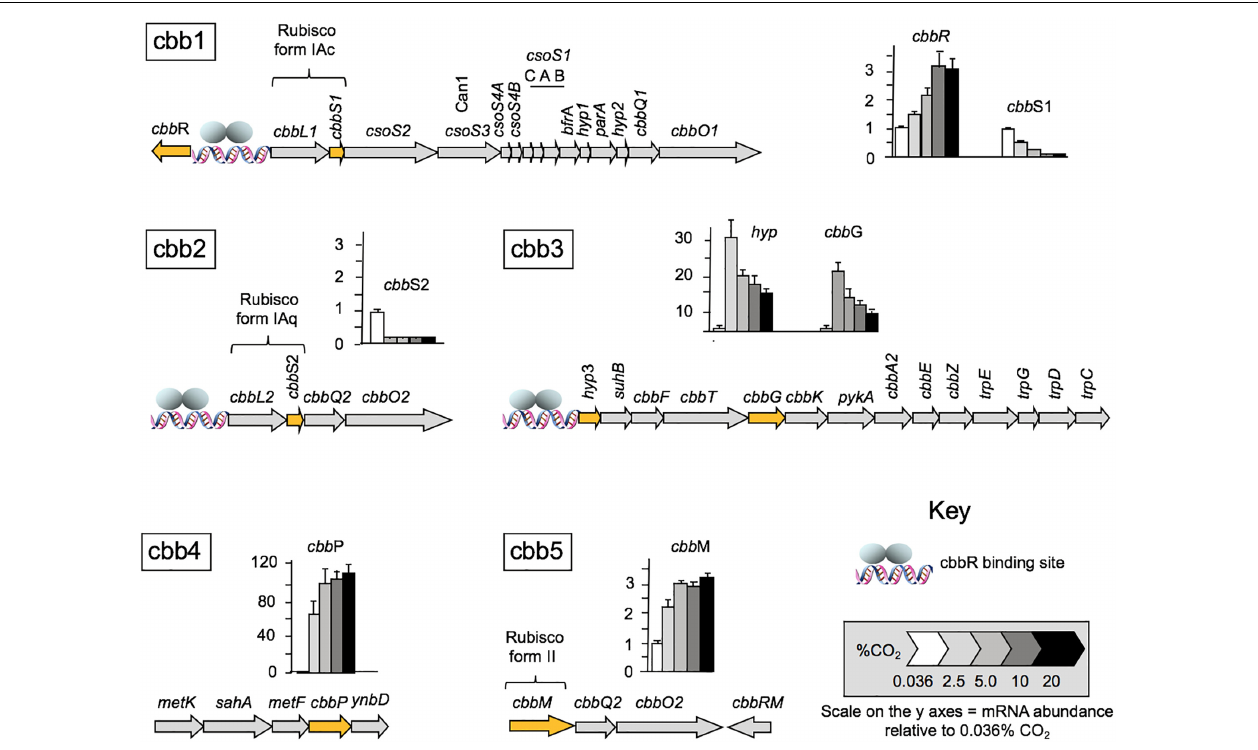
FIGURE 2 | RNA transcript levels for genes and corresponding cbb operons involved in A. ferrooxidans CO 2 assimilation under different CO 2 concentrations relative to the transcript levels in air (0.036% CO 2 ) normalized to one. mRNA abundance was determined by RT-qPCR ( n = 4) for the following genes: cbb R encoding the transcriptional regulator CbbR (cbb1); cbb S1 small subunit of RubisCO Form 1Ac (cbb1), cbb S2 small subunit of RubisCO form 1Aq (cbb2); hyp (hypothetical) and cbb G glyceraldehyde-3-phosphate dehydrogenase (cbb3); cbb P phosphoribulokinase (cbb4) and cbb M RubisCO form II (cbb5). The genes assayed in each operon are highlighted in orange. The cbbR responsive promotors are indicated with a DNA symbol and a cartoon of the two subunits of CbbR1 (gray ellipses). A full list of genes in the operons is provide in Table 1